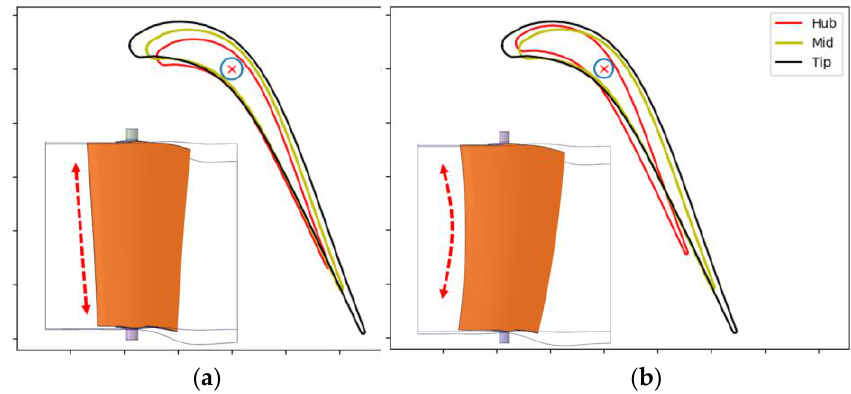
Figure 12. Radially restacked vanes, before and after . ( a ) Convex ( b ) Restacked .